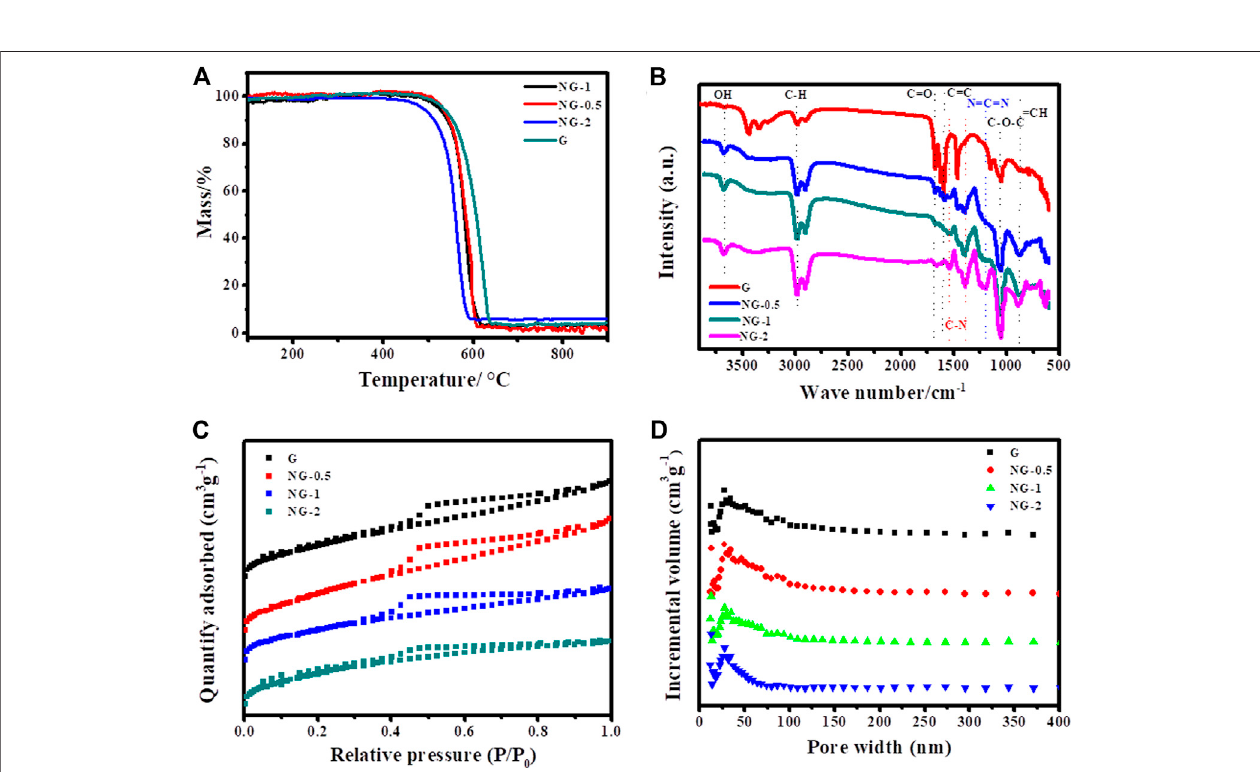
FIGURE 2 | (A) TGA curves, (B) FTIR spectra, (C) Nitrogen adsorption – desorption isotherms and (D) Pore size distributions of G, NG-0.5, NG-1 and NG-2.